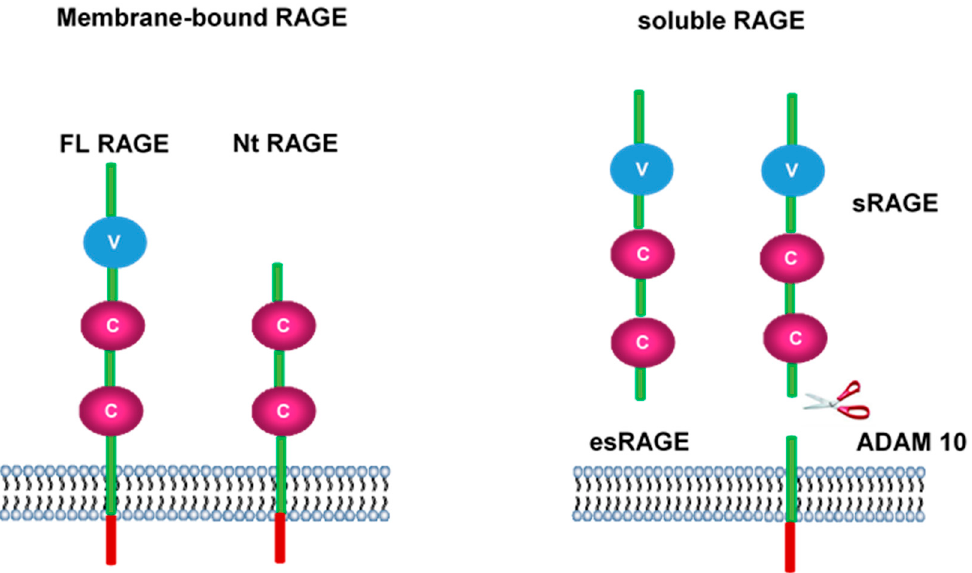
Figure 6. RAGE isoforms. The receptor for AGE (RAGE) can be produced as a complete molecule (full length, FL-RAGE) or as a dominant negative (Nt RAGE) which is a non-efficient receptor. Soluble forms of RAGE can result from an incomplete transduction of the gene (esRAGE) or from a proteolytic reaction by ADAM 10 metalloproteinase.